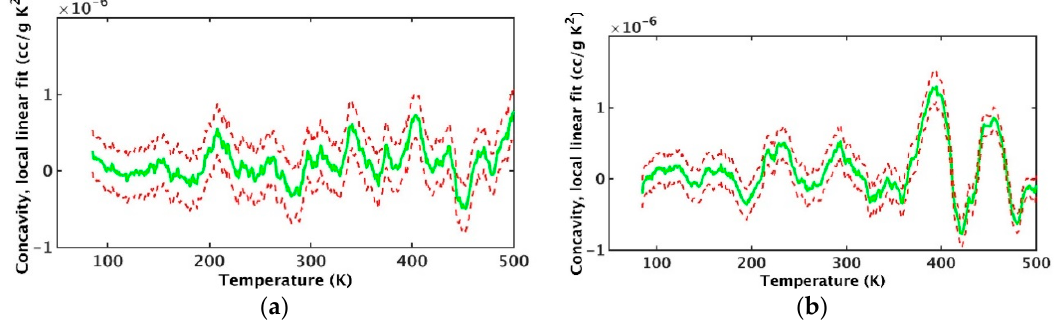
Figure 11. Local concavity versus temperature for short-chain etherified system for heating ( a ) and cooling ( b ). Dashed lines are the 95 percent confidence interval.